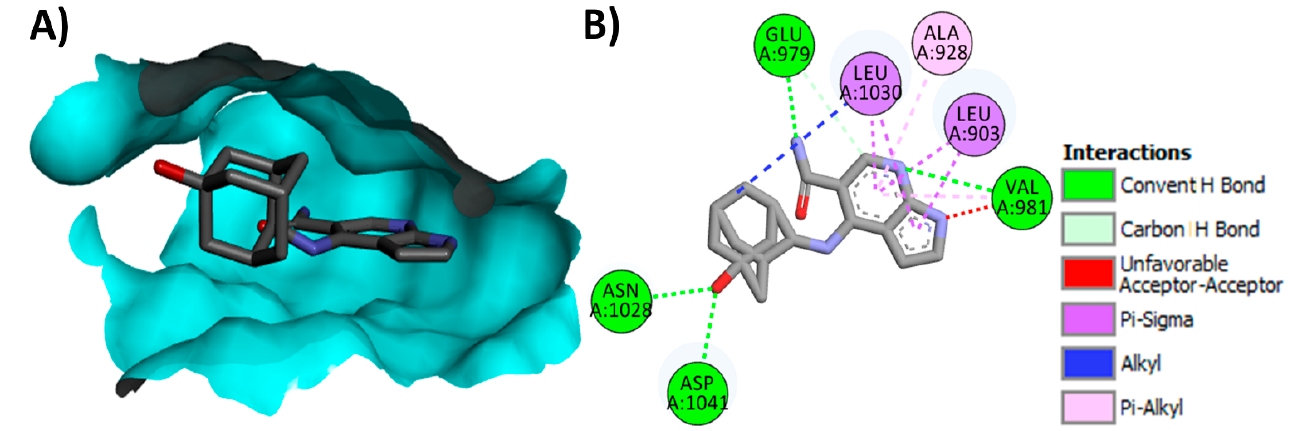
Figure 48. Binding modes of peficitinib (shown as sticks) into TYK2 (pdb: 6AAM): ( A ) 3D binding mode, receptor shown as a hydrogen bond surface; ( B ) 2D binding mode showing different types of interactions with TYK2; hydrogen atoms were omitted for clarity; this figure was generated using Discovery Studio Visualizer